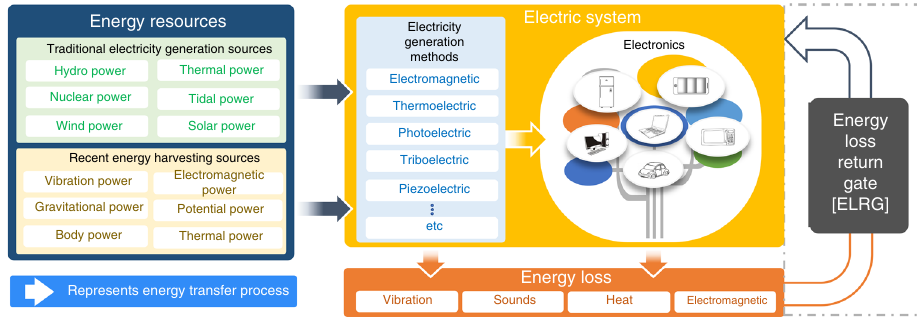
Fig. 1 ELRG is conceptualized to convert energy loss to available energy. Lines are added to show the energy transfer process in